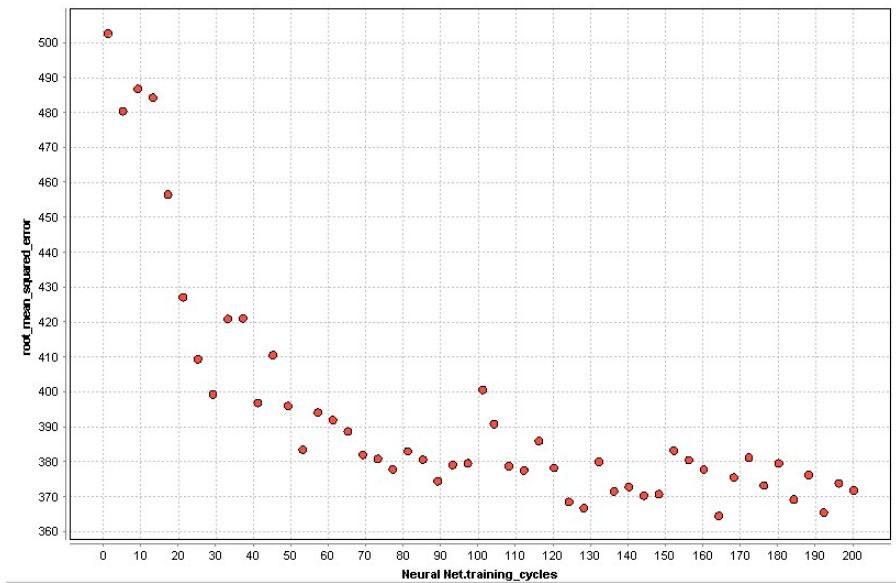
Figure 11. Training cycles tuning results for ANN model. Table 3. Parameter tuning